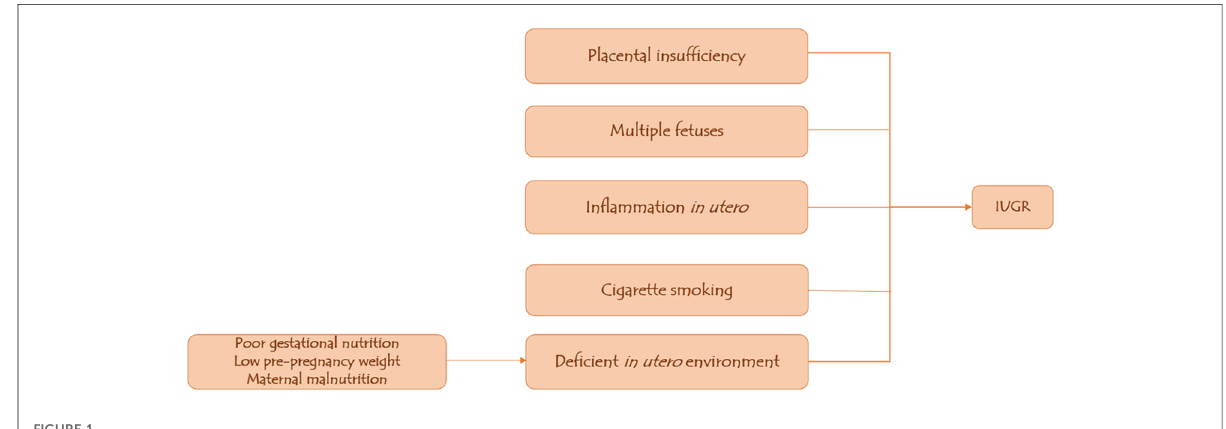
FIGURE 1 Predisposing factors to